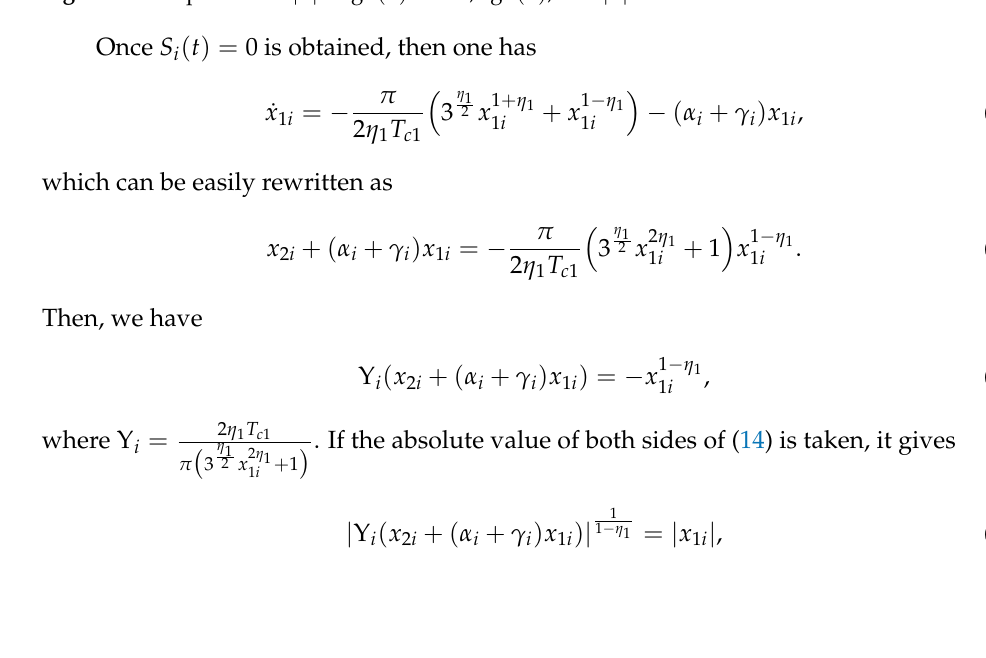
Figure 2. Comparison of | x | 0.7 sgn ( x ) and x , sgn ( x ) , and | x |